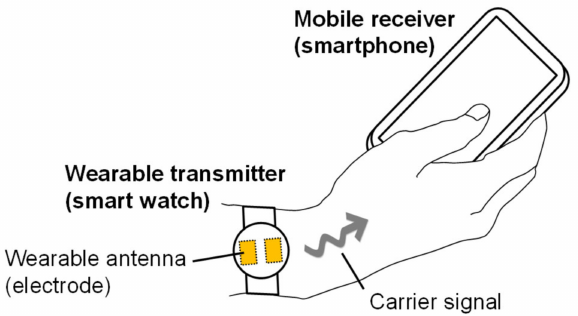
Figure 1. Proposed human body communication system.